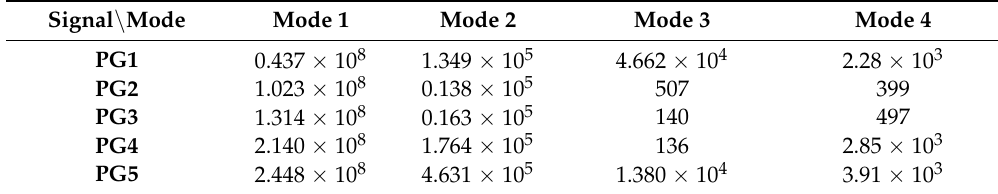
Table 5. NCF Matrix in Test Case 3.